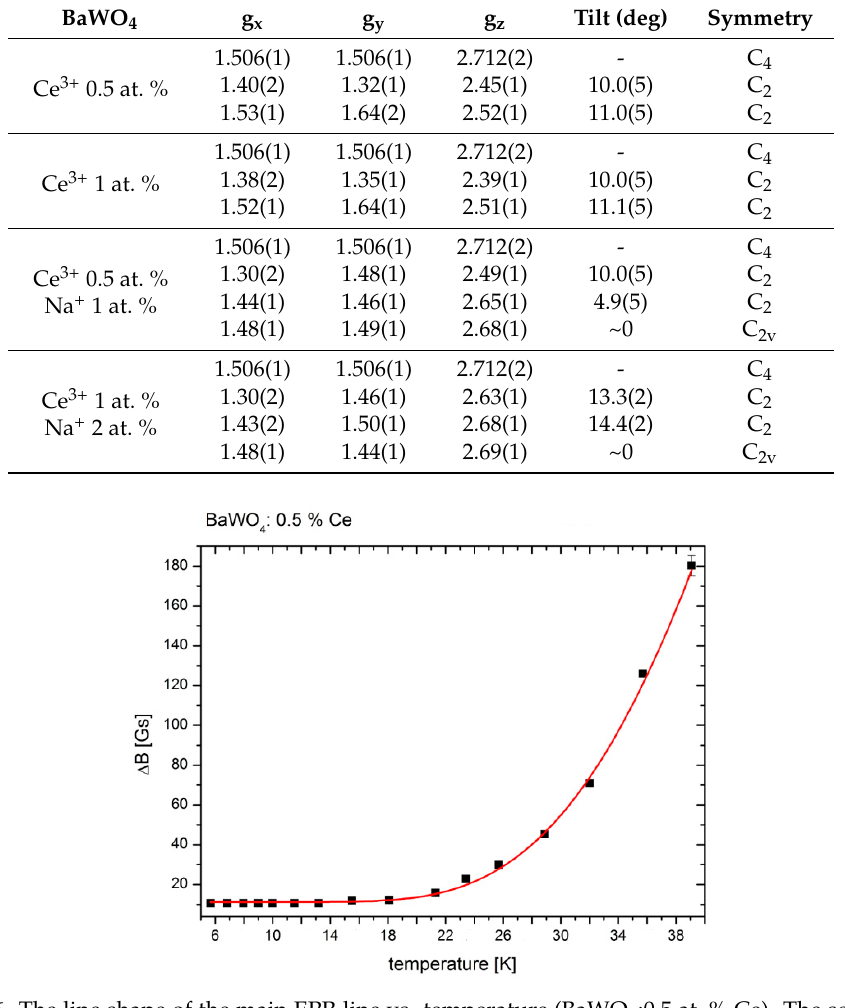
Figure 6. The line shape of the main EPR line vs. temperature (BaWO 4 :0.5 at. % Ce). The solid line reflects B = B o + Aexp( − W/kT) dependence.